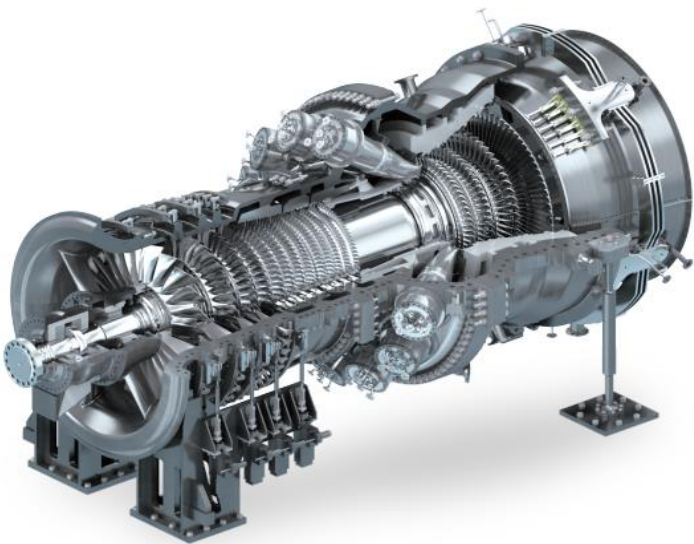
Figure 1. Example of an industrial gas turbine (Doosan